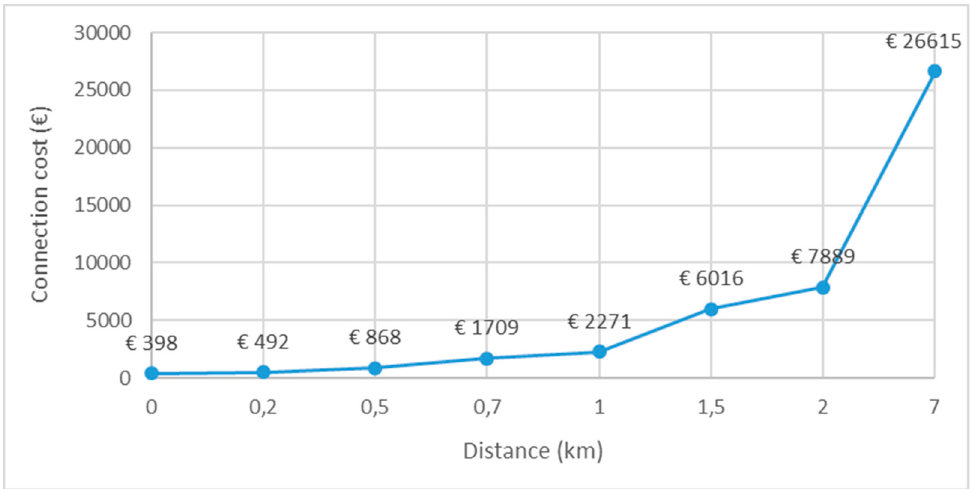
Figure 11. Grid connection cost vs. distance.